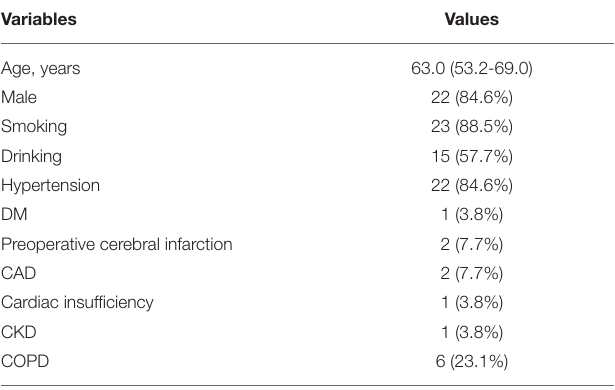
TABLE 3 | Results of patients receiving the MCPF